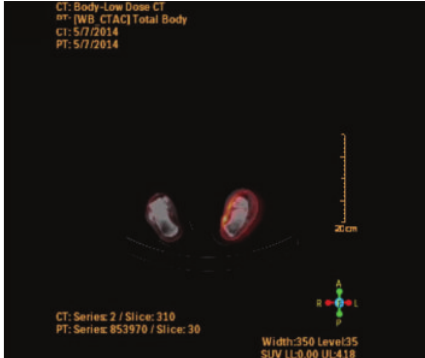
Figure 6: FDG-PET and CT scan showing heterogeneous uptake in the medial and lateral foot with a more focal uptake in the medial foot, anterior to the Achilles tendon.